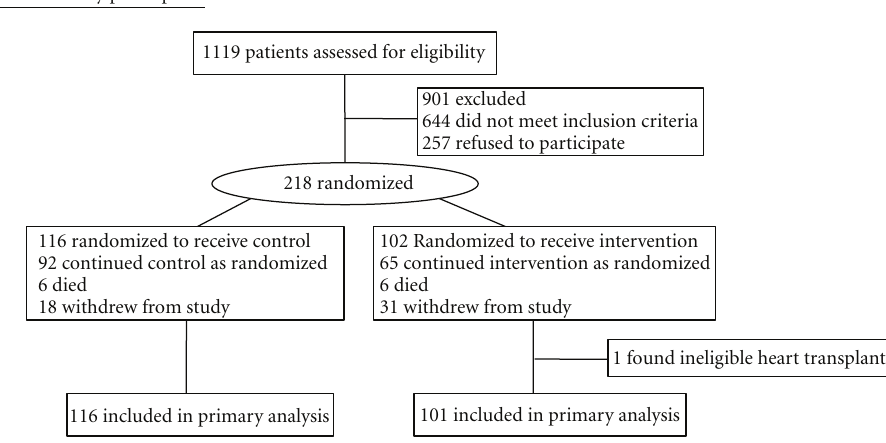
Figure 1: Consort